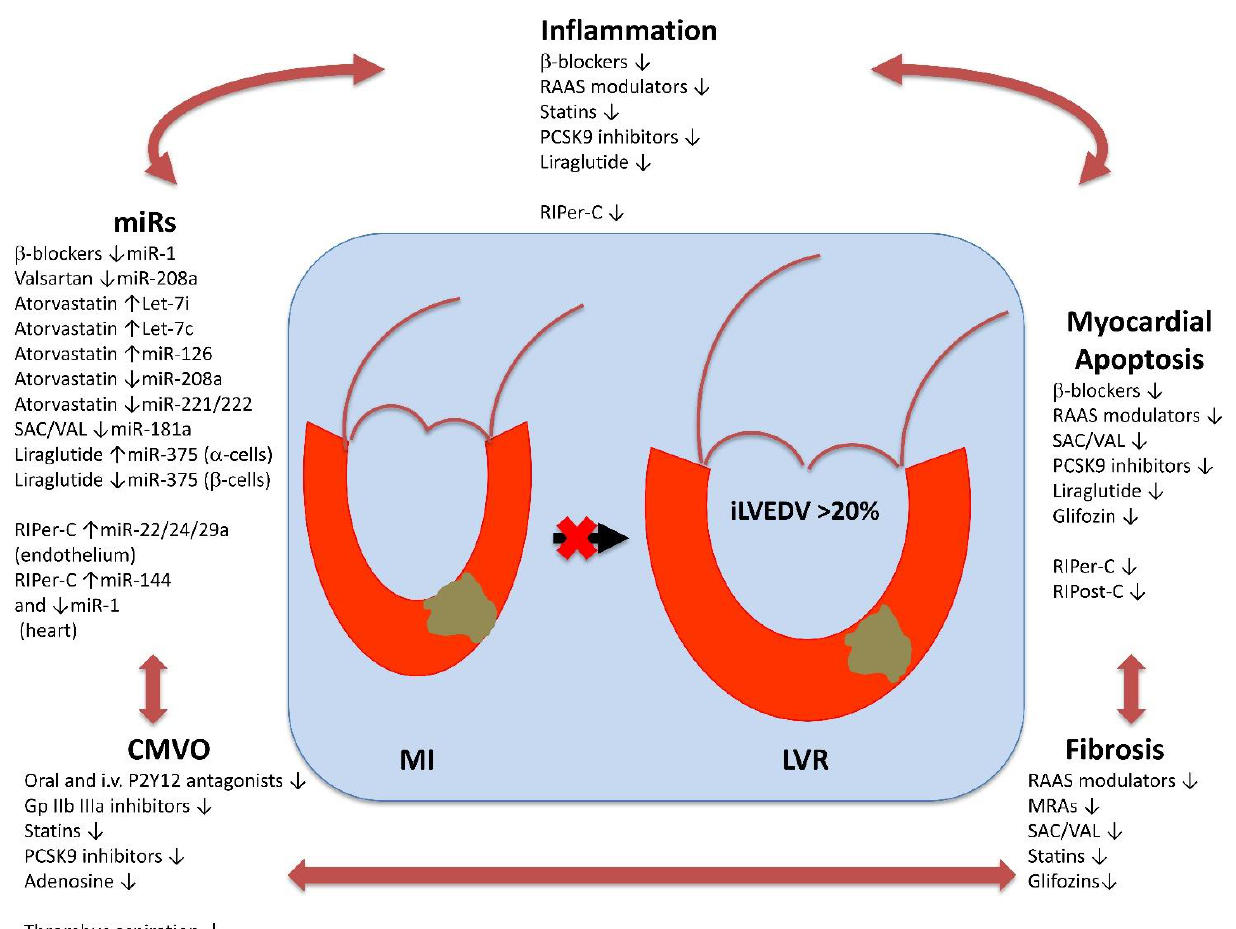
Figure 2. Principal effects of pharmacological therapies and mechanical interventions on pathophysiological determinants of post-STEMI LVR. LVR: left ventricular remodeling; STEMI: ST elevation myocardial infarction; RAAS: renin angiotensin aldosterone system; SAC/VAL: sacubitril/valsartan; PCSK9: proprotein convertase subtilisin/kexin type 9; Gp IIb IIIa; glycoprotein IIb IIIa; RIPer-C: remote ischemic perconditioning; RIPost-C: remote ischemic post-conditioning; miRs: micro-RNAs. ↑ indicates an increase; ↓ indicates a decrease.